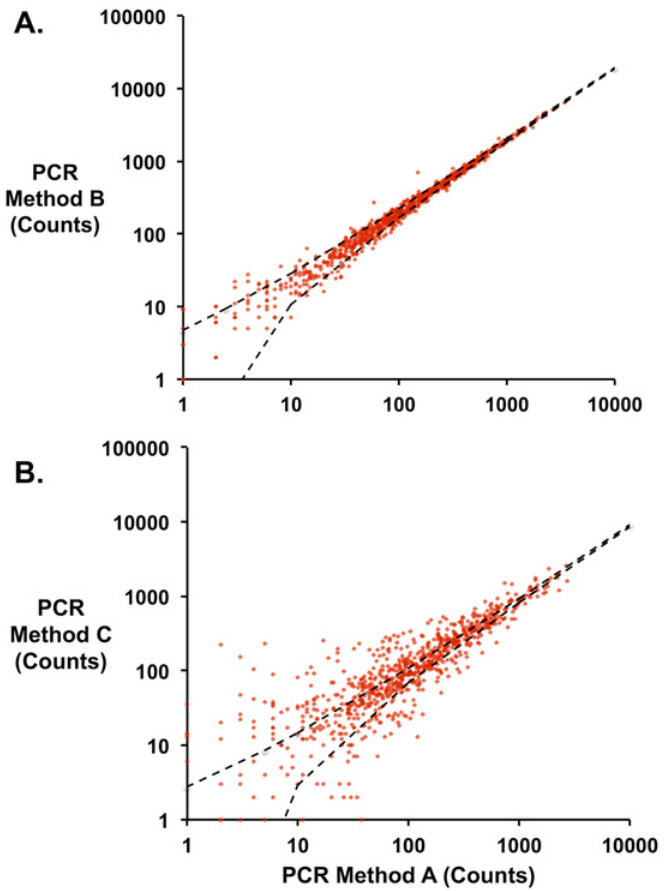
Fig 7. Errors introduced by different PCR methods. Identical mutant libraries were prepared for sequencing using three different PCR methods. The number of counts for each library member was compared across the different methods. Each point represents a specific mutant sequence. For each panel, dashed black lines represent the 95% confidence interval for the Poisson noise between different methods. A . Method B v. Method A. Above 10 counts, the data fall almost completely within minimal error predicted by Poisson noise. B . By contrast, Method C shows significant variance in counts relative to Method